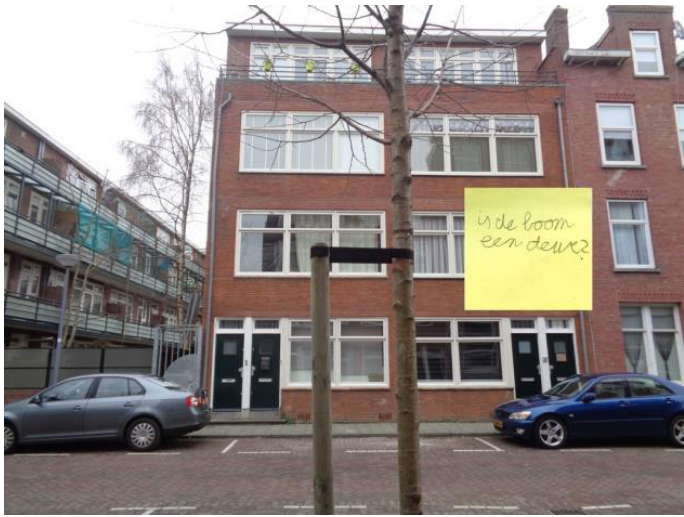
Figure 8. ‘Is the tree a door?’ .